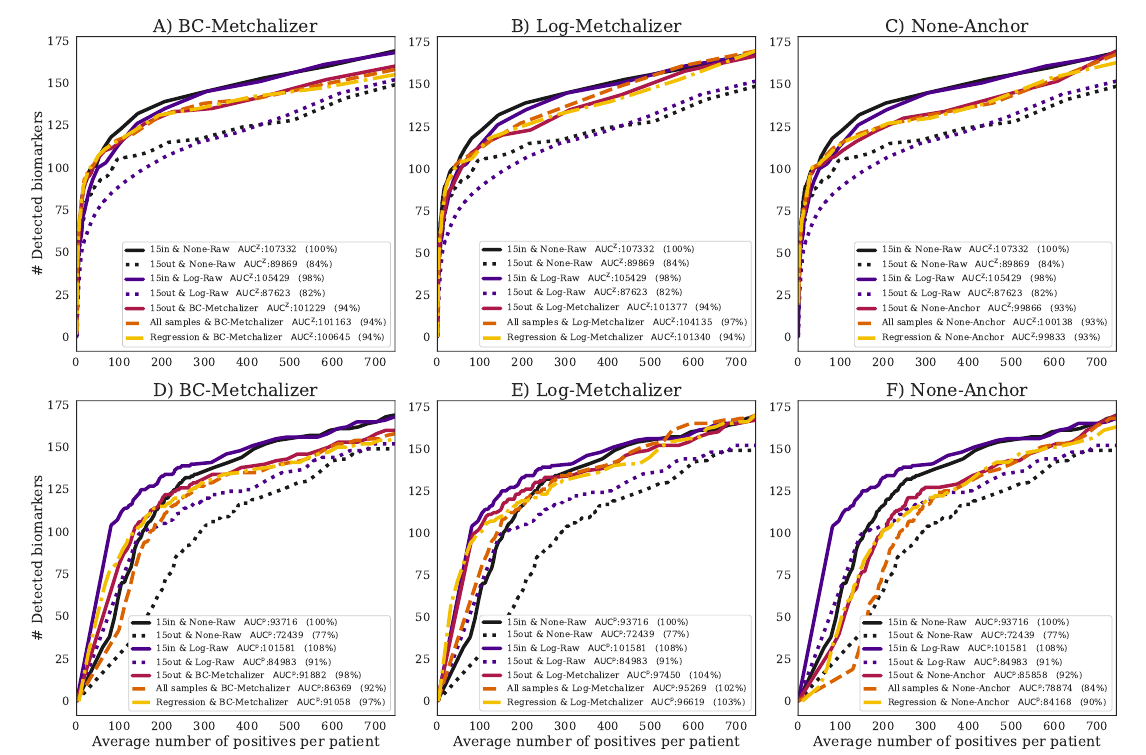
Figure 4. The number of detected expected biomarkers versus the average number of positives per patient. A curve in each (sub)figure was formed by increasing the Z-score or p -value threshold ( Z abnormal , Methods). The legend indicates (per curve) the methods used to determine Z-scores and how data was normalized, the AUC and AUC expressed as percentage of the AUC x Performances using ( A ) BC-Metchalizer and Z-scores, ( B ) Log-Metchalizer and Z-scores, ( C ) None-Anchor and Z-scores, ( D ) BC-Metchalizer and p -values, ( E ) Log-Metchalizer and p -values, and ( F ) None-Anchor and p